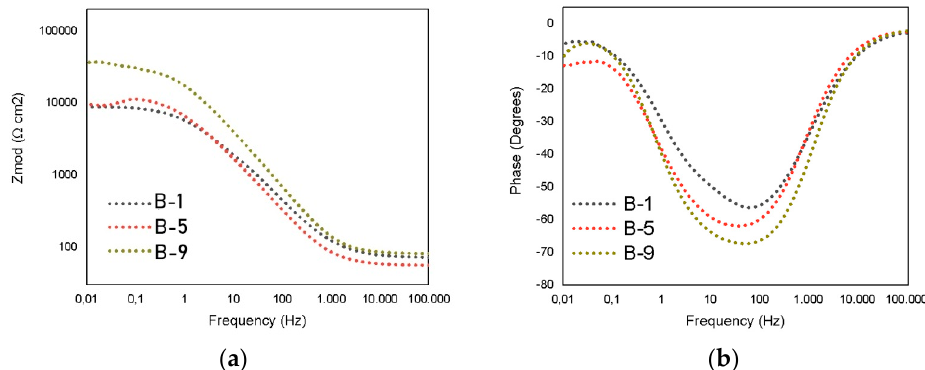
Figure 13. Spectra for Cu–Al coatings. ( a ) Impedance vs. frequency; ( b ) phase angle vs. frequency. The CPEs are a mathematical support that represents several elements of an electrical circuit.